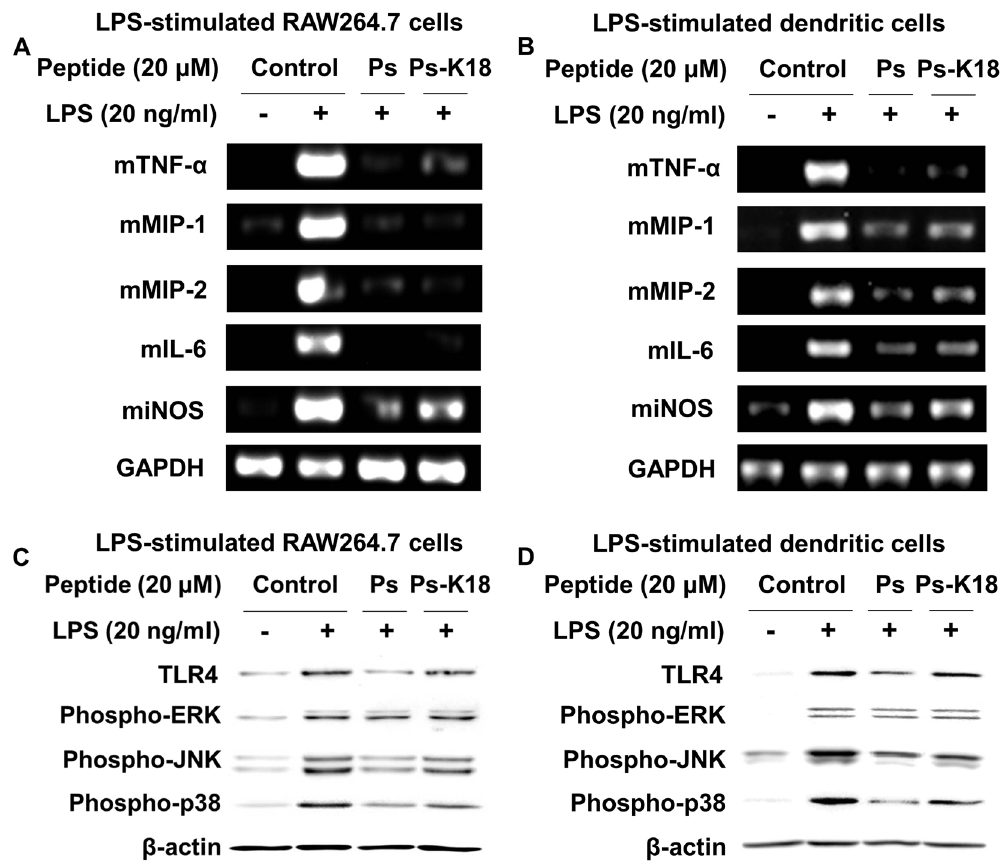
Figure 6. Effects of Ps and Ps-K18 on LPS-stimulated expression of pro-inflammatory cytokines in ( A ) RAW264.7 cells and ( B ) dendritic cells determined by reverse transcriptase polymerase chain reaction. Inhibition of inflammatory-related protein expression in LPS-stimulated ( C ) RAW264.7 cells and ( D ) dendritic